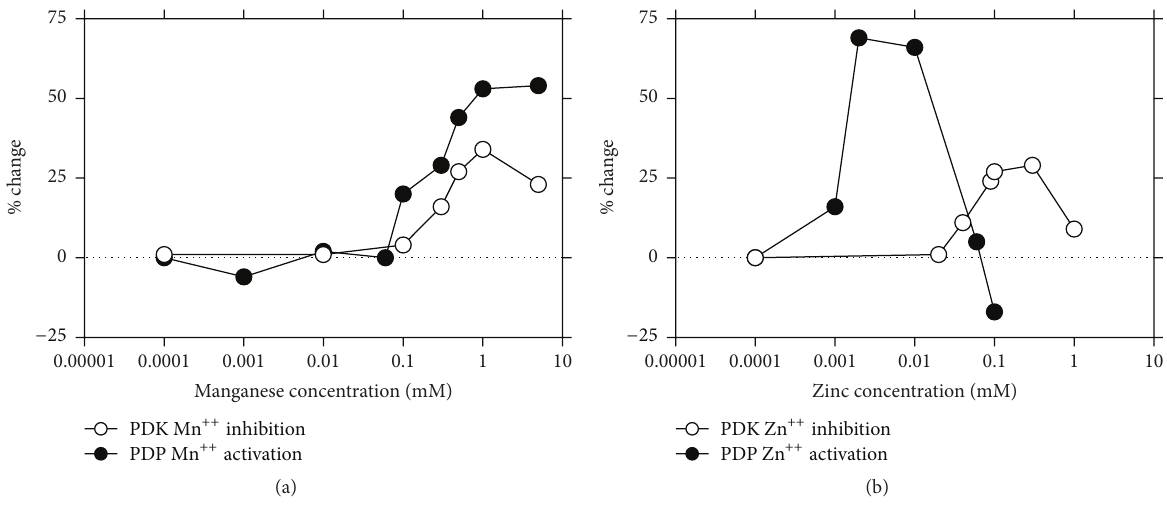
Figure 4: The activation of pyruvate dehydrogenase phosphatase (PDP) and the inhibition of pyruvate dehydrogenase kinase (PDK) are influenced by ion